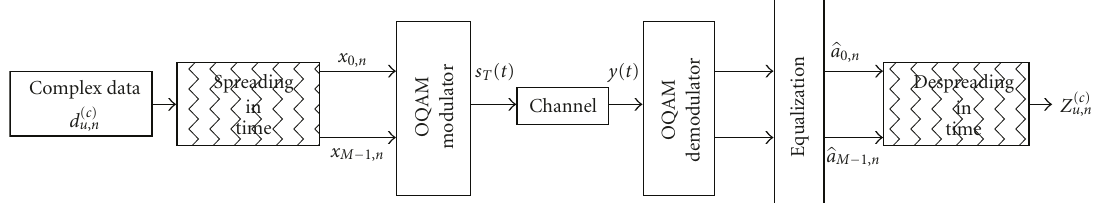
Figure 8: Transmission scheme for the CDMA-OFDM/OQAM system with spreading in time of complex